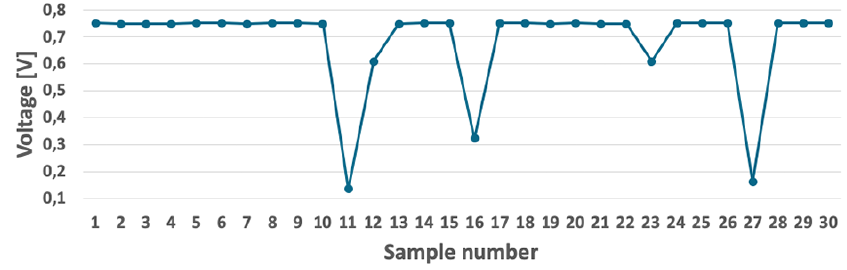
Figure 4. Example of light sensor readings collected during changes in light